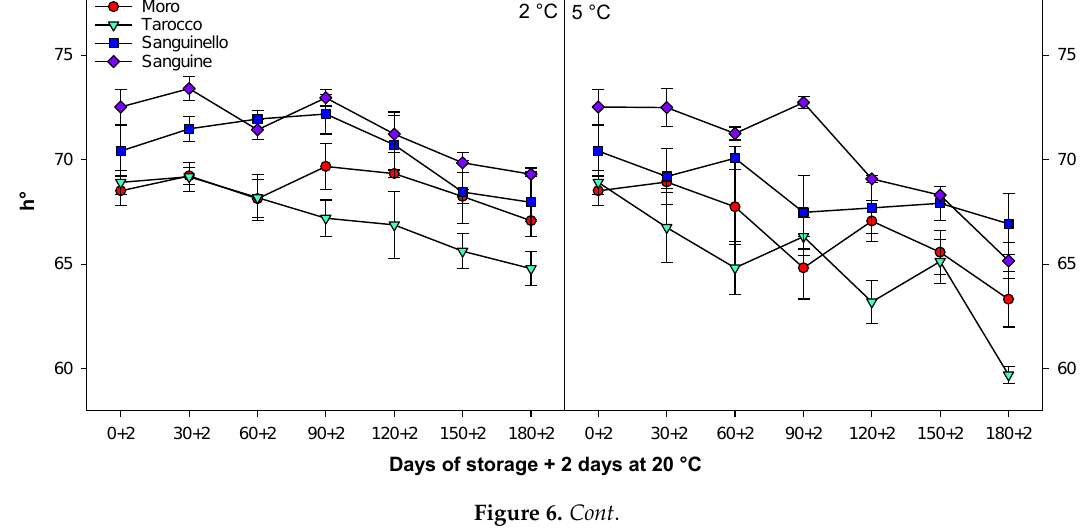
Days of storage + 2 days at 20 °C Figure 6. Cont